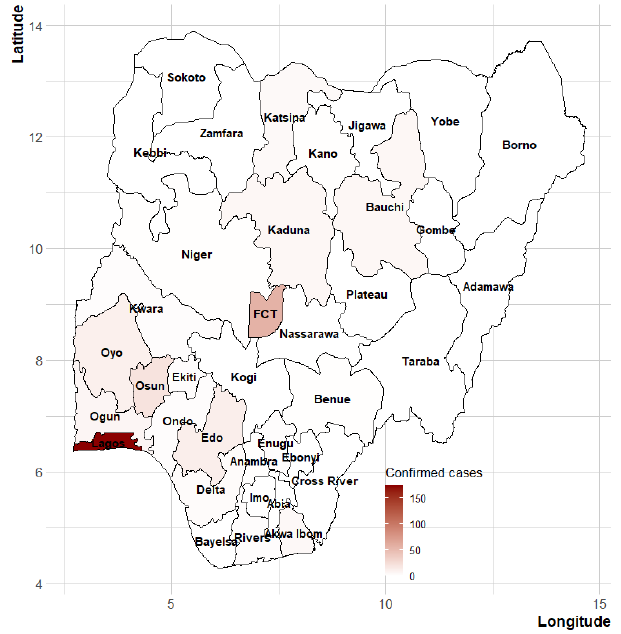
Figure A1. Map of Nigeria showing the distribution of cases of COVID-19 as at 11 April 2020. Int. J. Environ. Res. Public Health 2020 , 17 , x